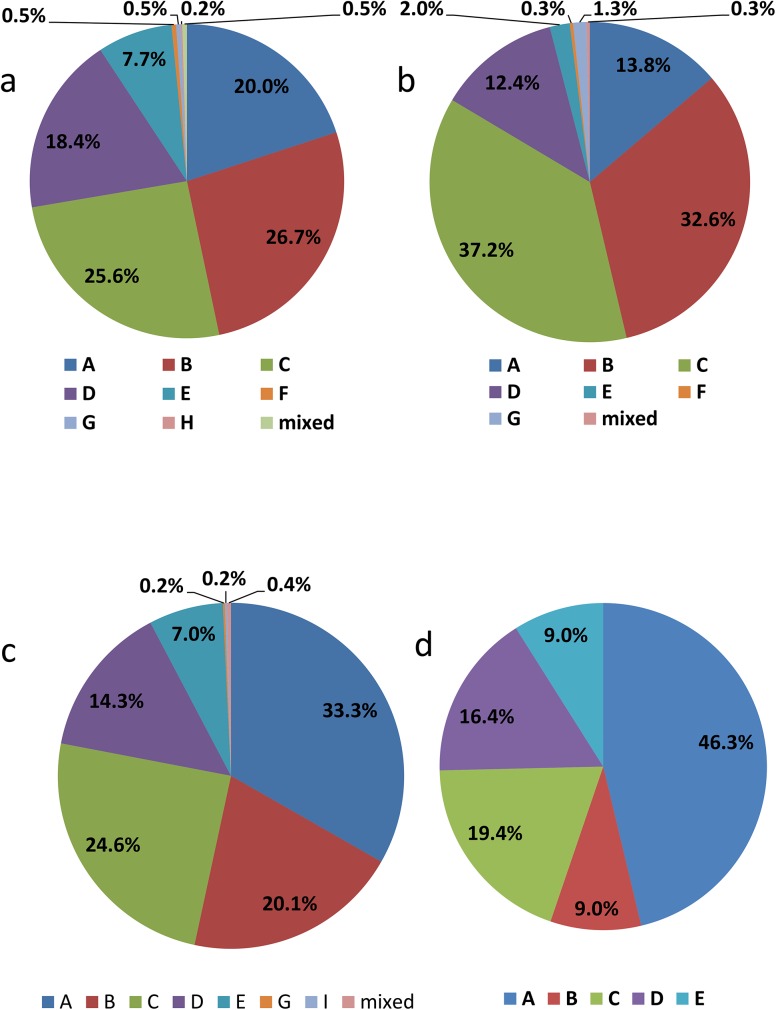
Genotype distribution for chronic HBV cases from Western Canada (n = 636; a), Central Canada (n = 298; b), the Prairies region (n = 532; c), and the Maritimes region (n = 67; d).